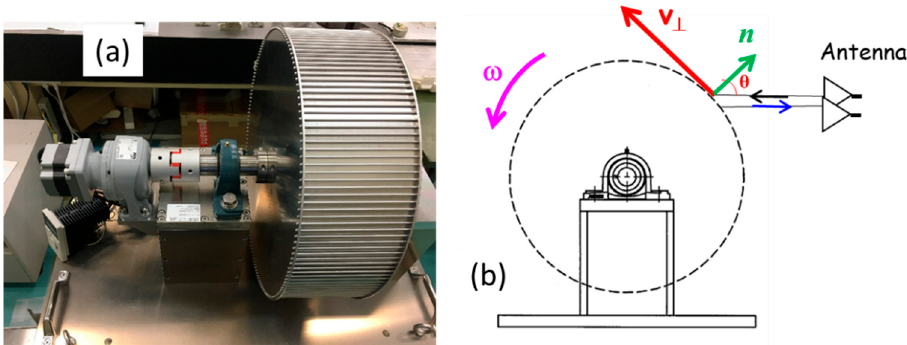
Figure 9. ( a ) Photograph of rotating grid drum and ( b ) Schematic layout of the test for the Doppler shift measurement.